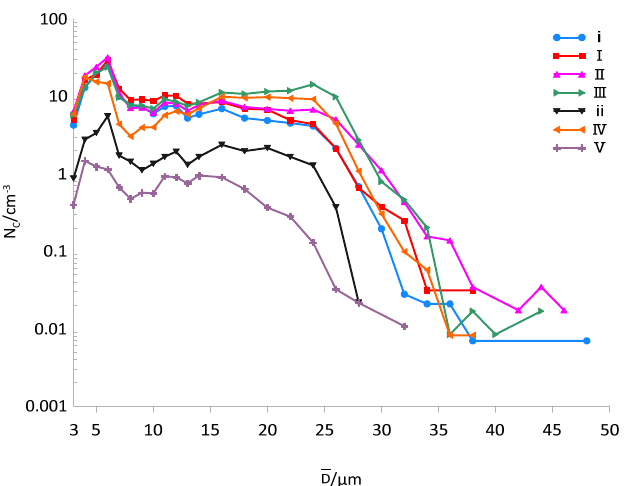
Figure 8. Droplet spectrum distribution at each stage of sea fog process in Beilun district from 20:55 on 14 June to 7:20 on 15 June 2021.